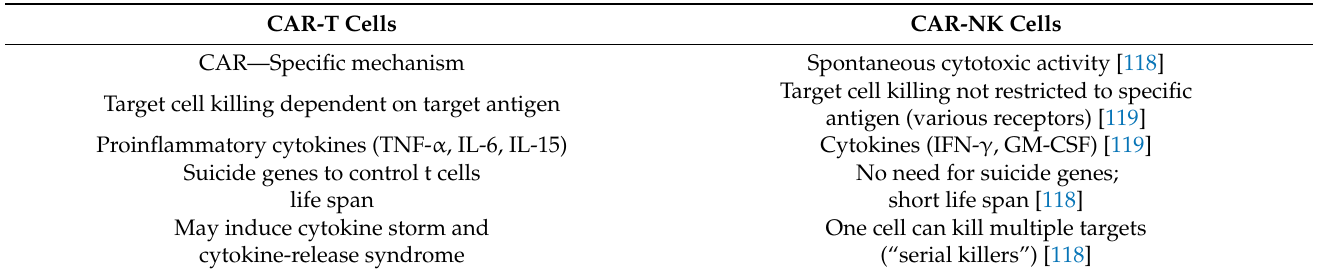
Table 3. Comparison of CAR-T and CAR-NK cells, their limitations and advantages in therapeutic use. CAR-T Cells CAR—Specific